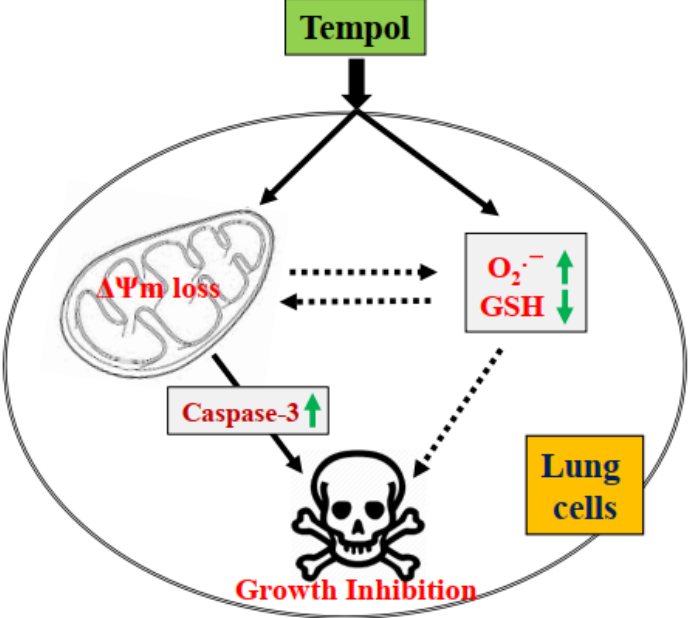
Figure 8. Schematic diagram of Tempol-induced growth inhibition of lung cells.